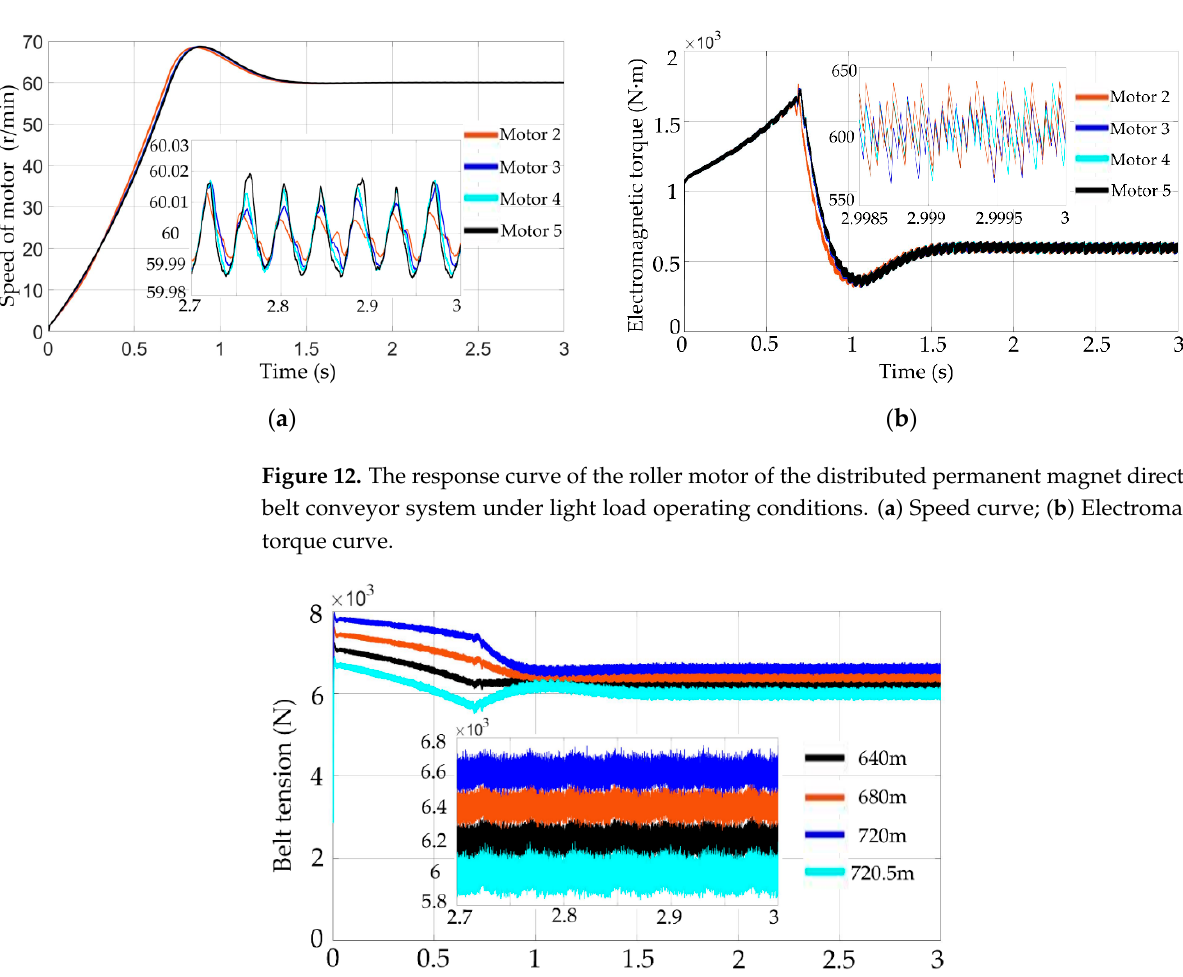
Figure 12. The response curve of the roller motor of the distributed permanent magnet direct-drive belt conveyor system under light load operating conditions. ( a ) Speed curve; ( b ) Electromagnetic torque curve.